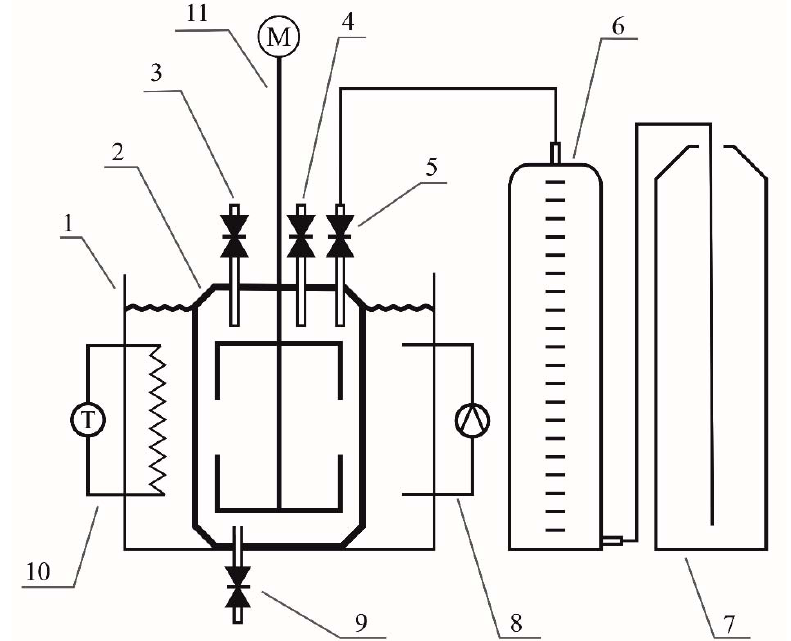
Figure 1. The digester used in the experiment for the production of biogas in the continuous